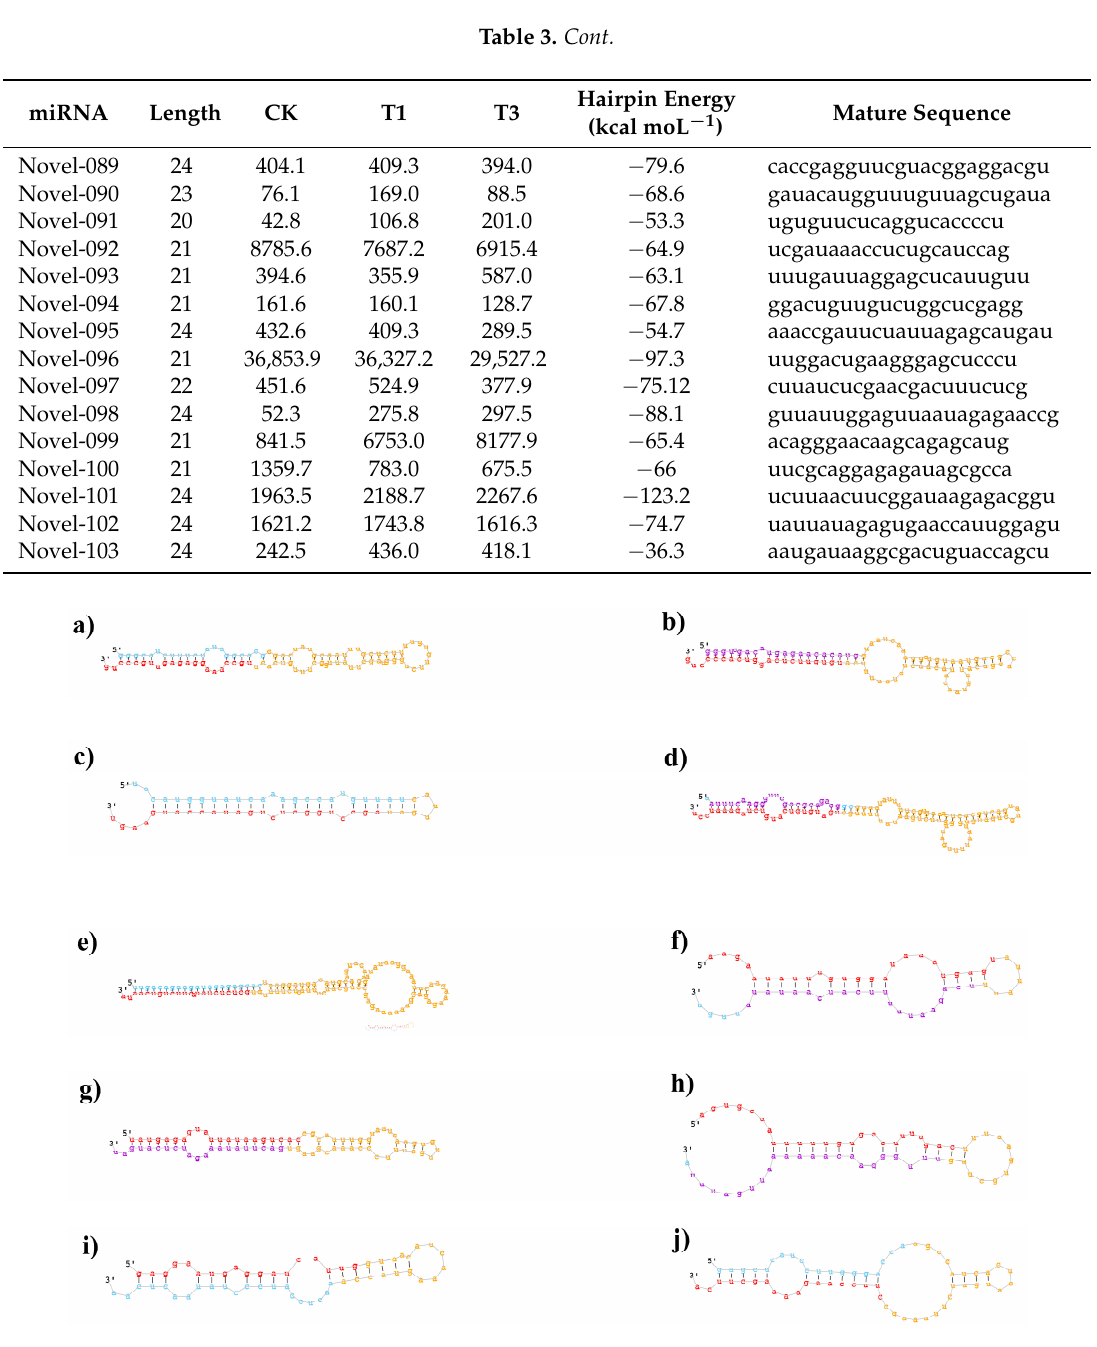
Figure 3. Predicted secondary structures of selected eight novel miRNAs in our study. The red indicates mature miRNA sequences, yellow indicates ring structure and purple indicates star sequences. ( a ) Novel-004; ( b ) Novel-036; ( c ) Novel-013; ( d ) Novel-018; ( e ) Novel-049; ( f ) Novel-059; ( g ) Novel-073; ( h ) Novel-092; ( i ) Novel-010; ( j ) Novel-015.